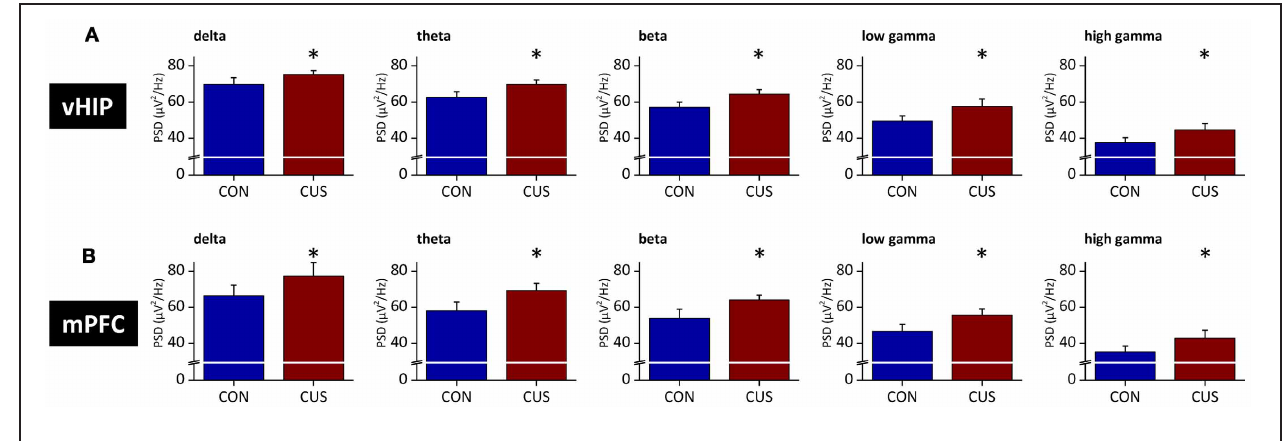
FIGURE A3 | Stressed rats show increased PSD in multiple frequency bands both in the ventral hippocampus and medial PFC in the second set of rats. Group comparison of the power spectral density (PSD) values from vHIP (A) and